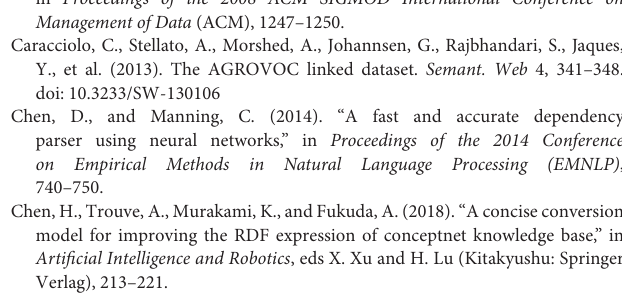
semantic relations between graph entities and classes. The output produced by FoodKG can be queried using a SPARQL engine through a friendly user interface. We evaluated AGROVEC using the Spearman Correlation Coefficient algorithm, and the results show that our model outperforms the other models trained on the same graph